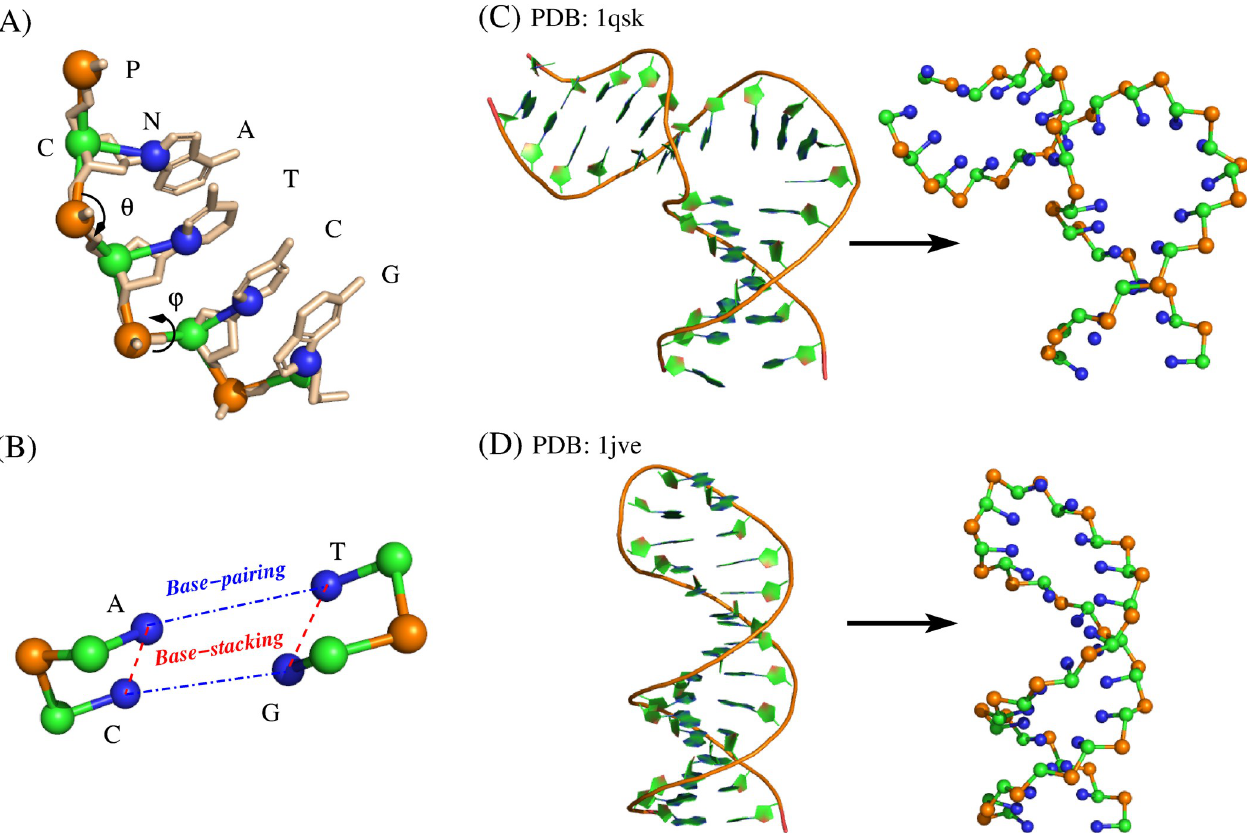
Fig 1. The representations of all-atom and CG model for each deoxynucleotide and ss/dsDNA molecules, as well as the schematics of base-pairing and base-stacking in the present model. (A) Our coarse-grained representation of a DNA fragments including deoxynucleotides of A, T, G, and C superimposed on the all-atom representation. The three beads are located at phosphate (P), sugar (C4’) and pyrimidine (N1) or purine (N9). θ and φ are the schematics of CG bonded angle (CPC) and dihedral (CPCP), respectively. (B) The schematic representation of base-pairing (blue) and base-stacking (red) interaction. (C,D) The 3D structures of (C) a dsDNA with bulge loop (PDB:1qsk) and (D) an ssDNA hairpin (PDB: 1jve) in all-atomistic (left) and our CG representation (right). The 3D structures are shown with PyMol (http://www.pymol.org).